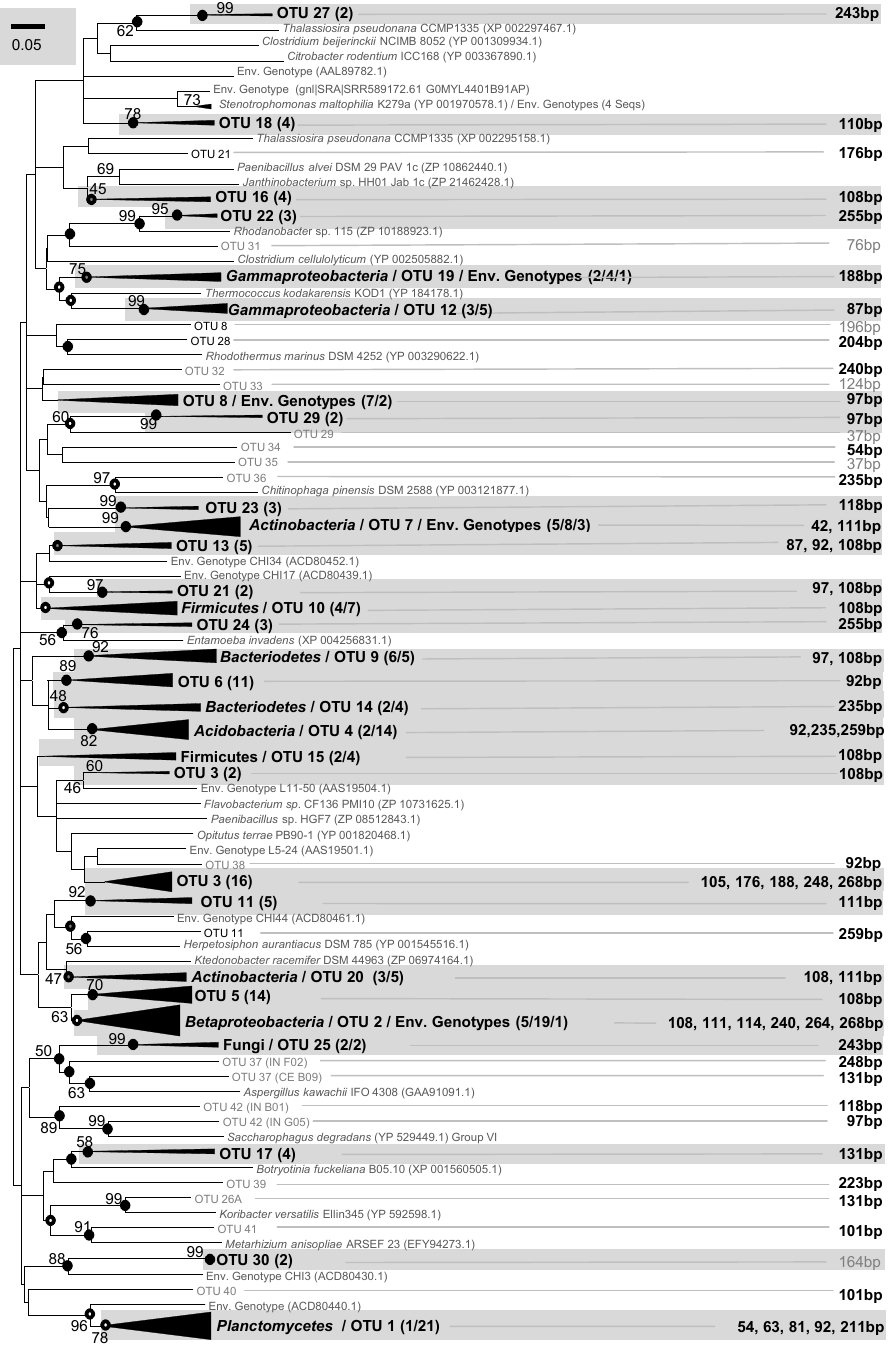
Figure 5. Phylogenetic tree of chiA OTUs (206 sequences) and references (78 sequences). The expanded tree is presented in Fig. S3. chiA gene libraries were prepared from pooled DNA extracts of each substrate treatment and data were combined for the figure. Gray numbers in parentheses, accession numbers of reference sequences. For condensed branches OTUs and taxonomic affiliation of reference sequences are indicated in bold letters and the numbers of reference sequences, OTU sequences and environmental sequences are given in parentheses. Accession numbers for reference sequences of the condensed branches can be found in Fig. S3. Numbers on the right side, TRFs corresponding to genotypes identified by in silico analysis. The tree was calculated using translated amino acid sequences with neighbor- joining algorithm (MEGA 5; Tamura et al., 2011) including bootstrapping (1000 replicates; percentage values at nodes). Open circles and gray filled circles at nodes, these nodes were confirmed by maximum likelihood and maximum parsimony algorithms, respectively, using the same data set. Black circles, confirmation by both algorithms. Scale bar, 5% sequence